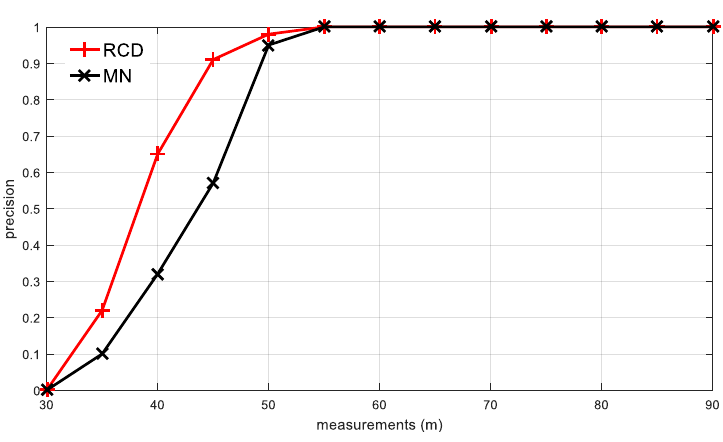
Figure 9. Comparison of RCD and MN (changed measurements).